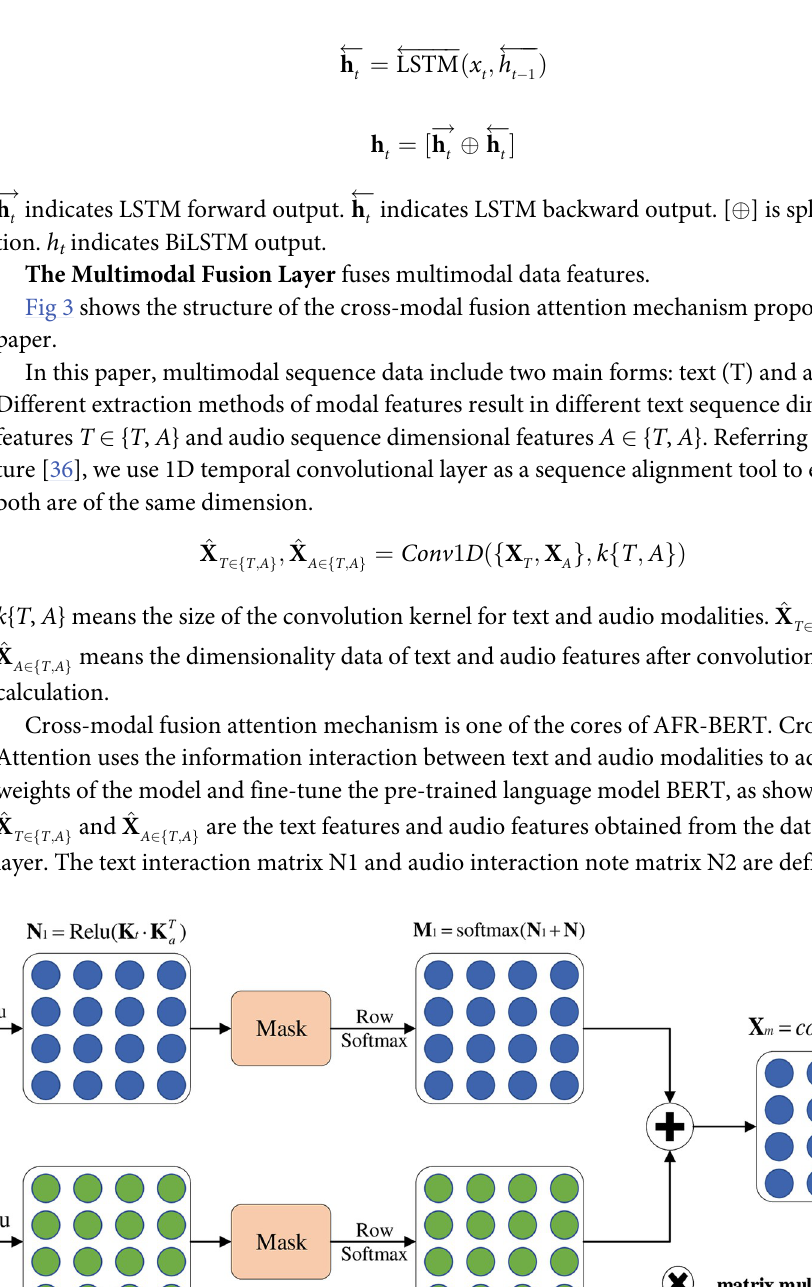
) represents text feature data. ( K ) represents audio feature data. (Relu, Row Softmax, t a